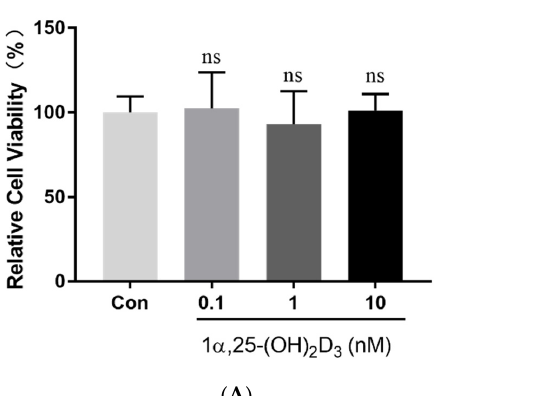
Figure 1. OCP viability was not affected by 1 α ,25-(OH) 2 D 3 . ( A ) Cell viability detected by CCK-8 24 h after treatment with different concentrations of 1 α ,25-(OH) 2 D 3 . ( B ) Cell viability detected by CCK-8 24 h after treatment with 10 nmol/L 1 α ,25- (OH) 2 D 3 in the absence or presence of 50 ng/mL RANKL. Data are shown as means ± SD. n = 6, ns, p > 0.05; ** p < 0.01 . 2.2. 1 α ,25-(OH) 2 D 3 Promoted Gal-3 Expression To elucidate the effect of 1 α ,25-(OH) 2 D 3 on gal-3 protein expression, 0.1, 1, and 10 nmol/L 1 α ,25-(OH) 2 D 3 were added to the culture medium during OC formation induced by 25 ng/mL M-CSF and 50 ng/mL RANKL for 3 days. 1 α ,25-(OH) 2 D 3 upregulated gal-3 protein expression in a dose-dependent manner (Figure 2). The 10 nmol/L 1 α ,25-(OH) 2 D 3 group had a higher level of gal-3 protein expression than that in the other groups.